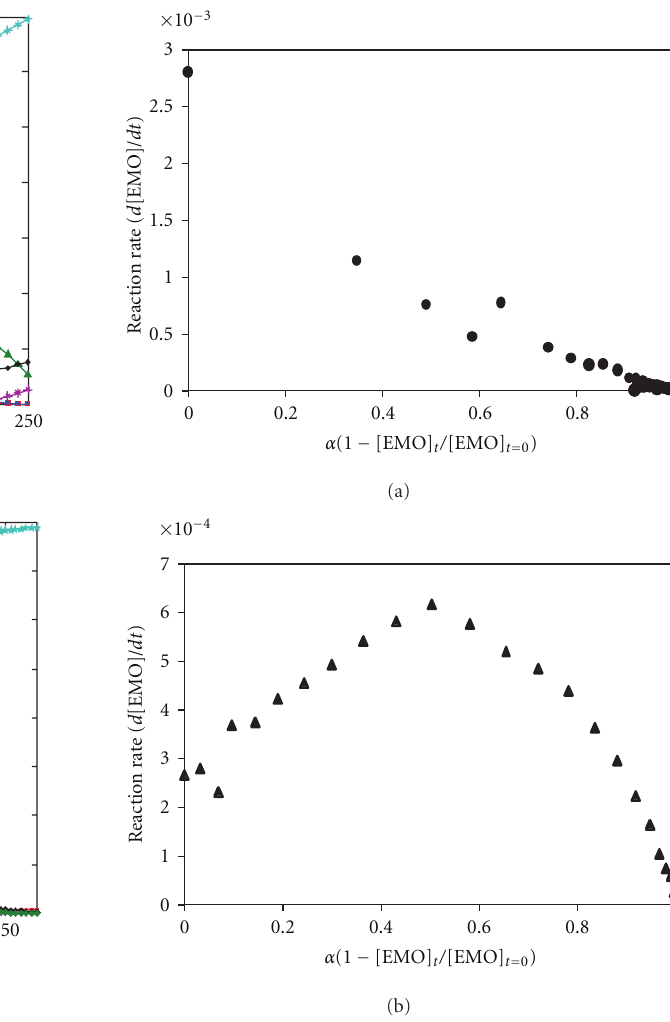
Figure 4: Reaction rate versus conversion ( α ): (a) 60 ◦ C; (b) 30 ◦